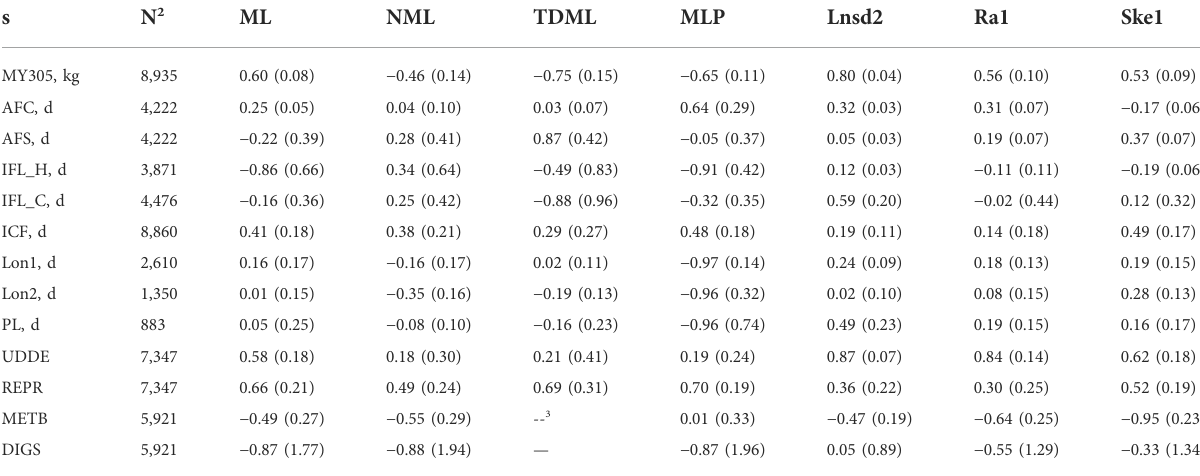
TABLE 5 Genetic correlations between milk loss traits, variability traits and production, reproduction, longevity, and health